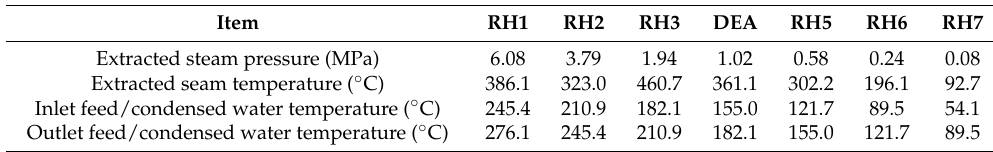
Table 2. Details of the regenerative heating